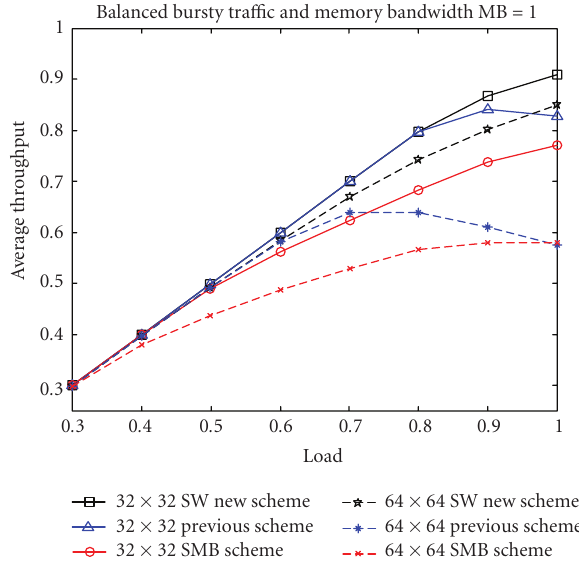
Figure 6: Average throughput with memory bandwidth (MB = 1) of SW and SMB switches.